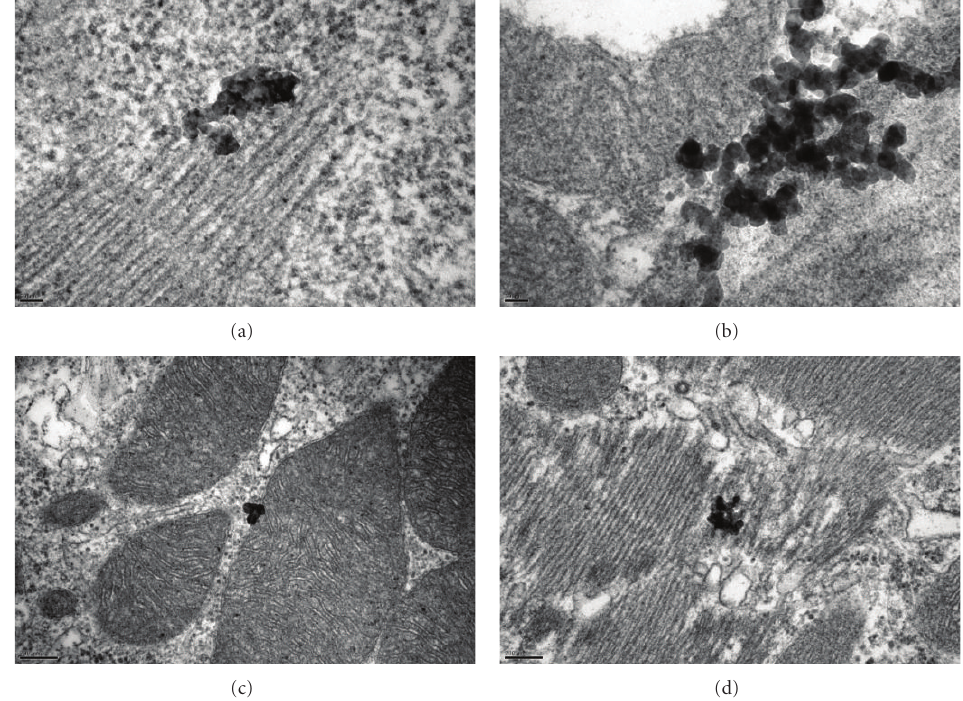
Figure 8: TEM image of the skin of the common carp ( Cyprinus carpio ) exposed to Ag-NPs for 96h. (a) 25 µ g/L. Epidermis. (b) 50 µ g/L. Epithelium. (c) 100 µ g/L. Mitochondrion in epithelium. (d) 200 µ g/L. Epithelium.